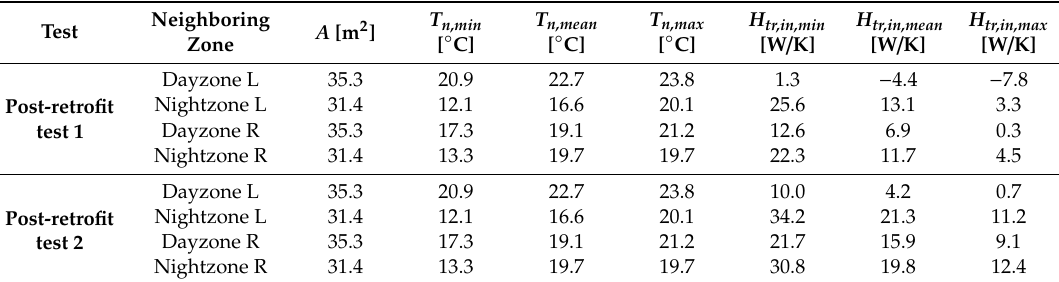
Table 7. Transmission heat losses towards the neighboring heated dwellings on the left-hand side (L) and the right-hand side (R) of the assessed case